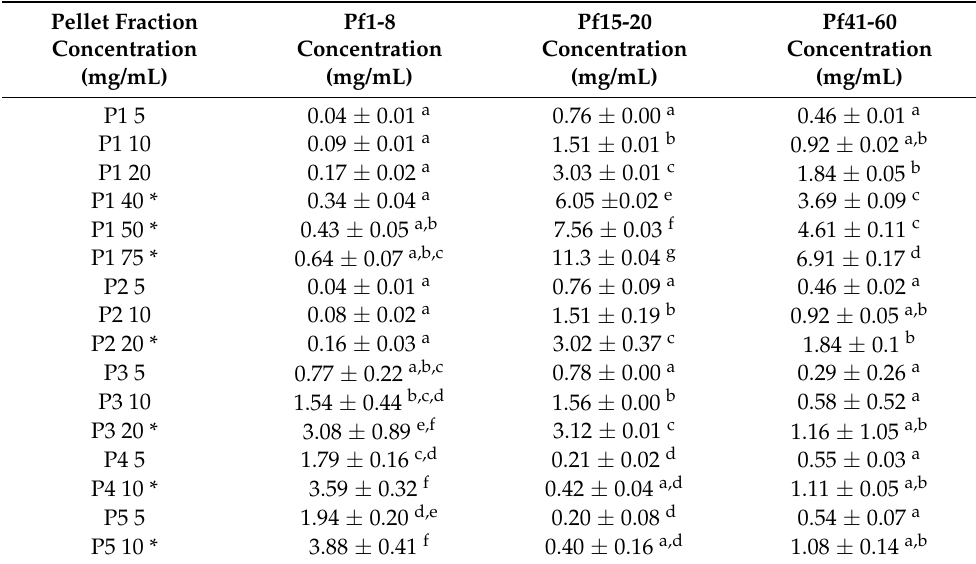
Table 4. Concentrations of peptides Pf1-8, Pf15-20, and Pf41-60 in pellets (P1 to P5) for each solution assessed for gelling